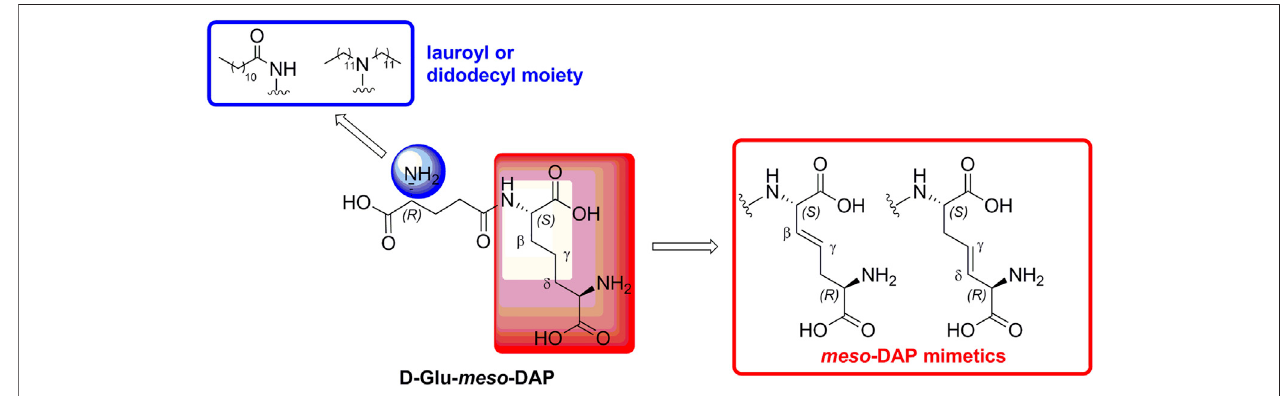
FIGURE 1 | Structural modi fi cations of the parent D-Glu- meso -DAP (iE-DAP) resulting in conformationally constrained analogs.